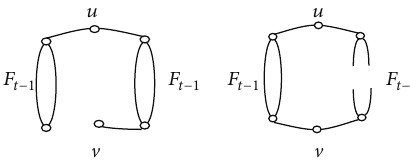
Figure 4: The number of spanning trees of 𝐹 𝑡 .